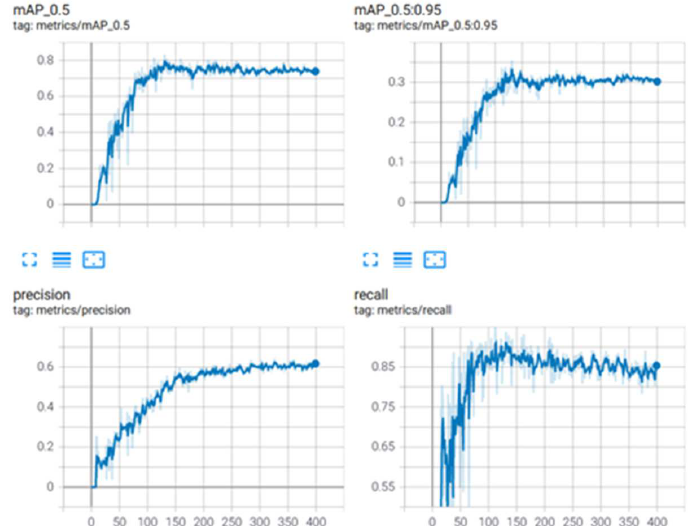
Figure 12. Metrics for scaled YOLOv4 for parasite classification.